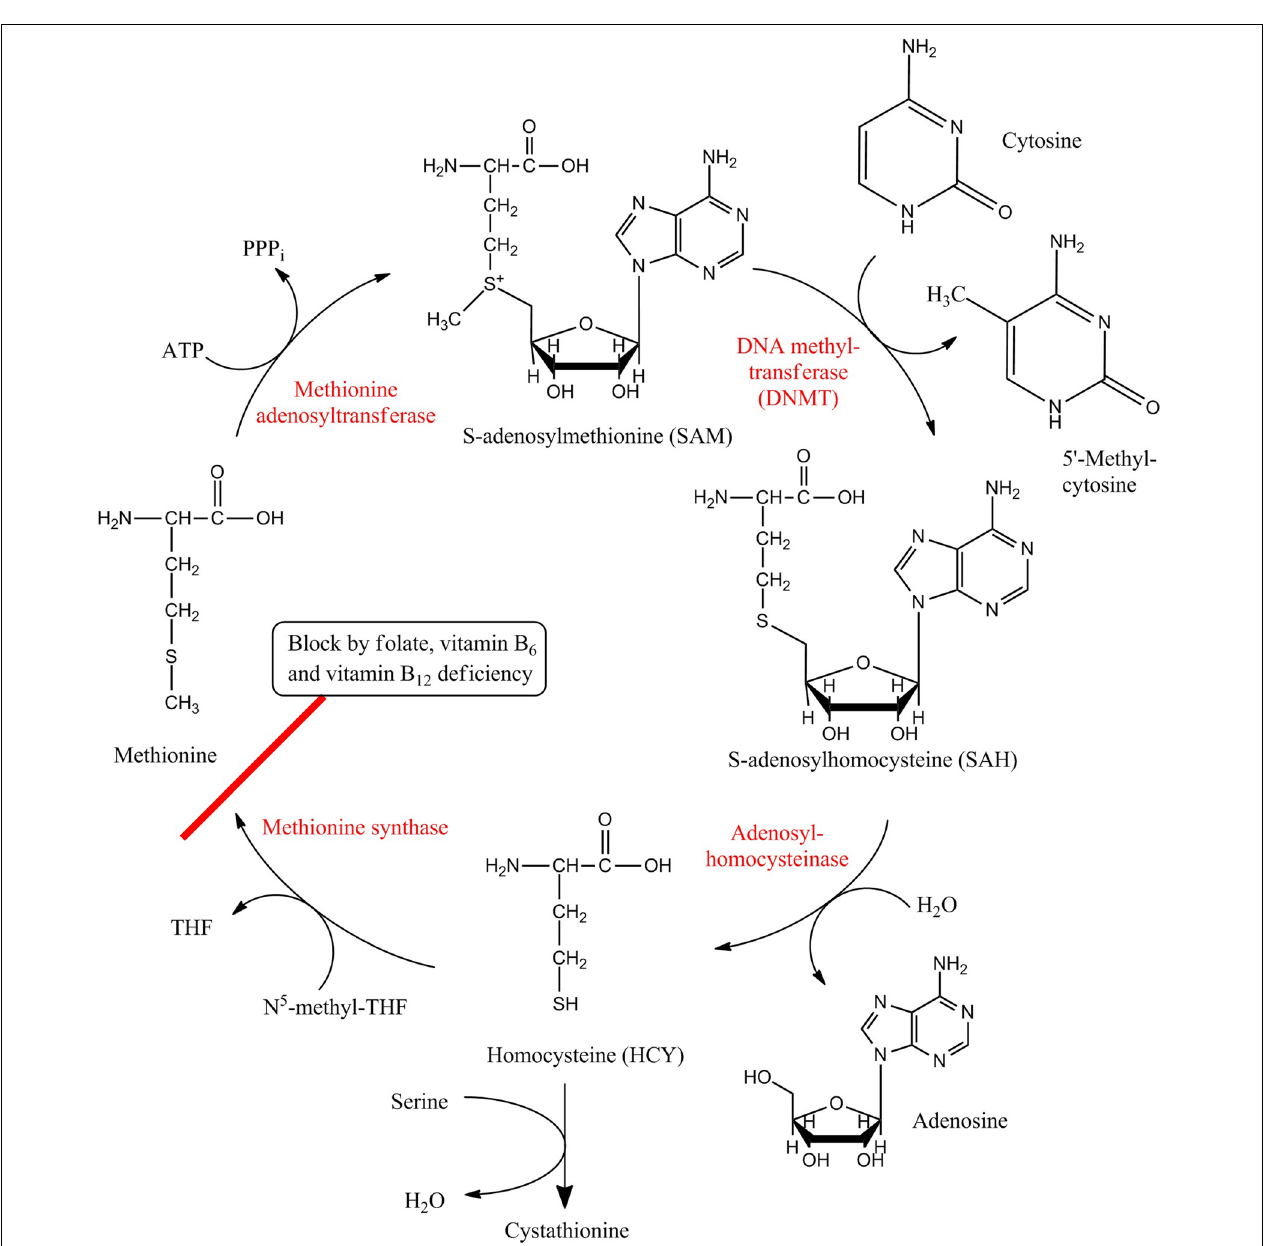
FIGURE 1 | Metabolic pathway of DNA methylation. HCY/SAM cycle ensures the continuous transport of methyl group from SAM to cytosine, providingtherawmaterialofDNAmethylation.Enzymesareshowninredwhile